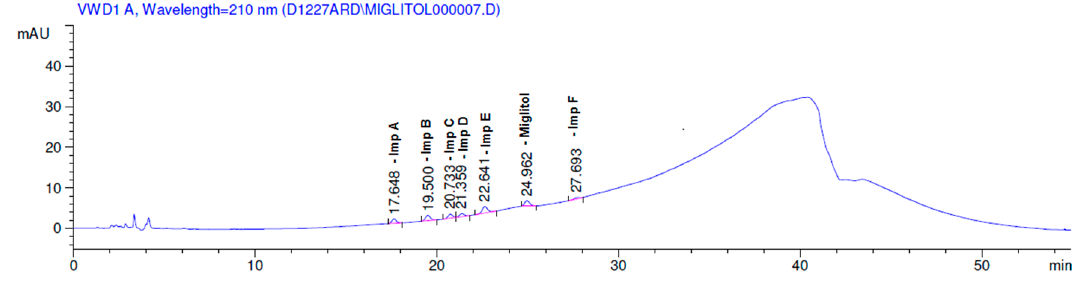
Figure 13. Limit of quantitation solution of miglitol and other